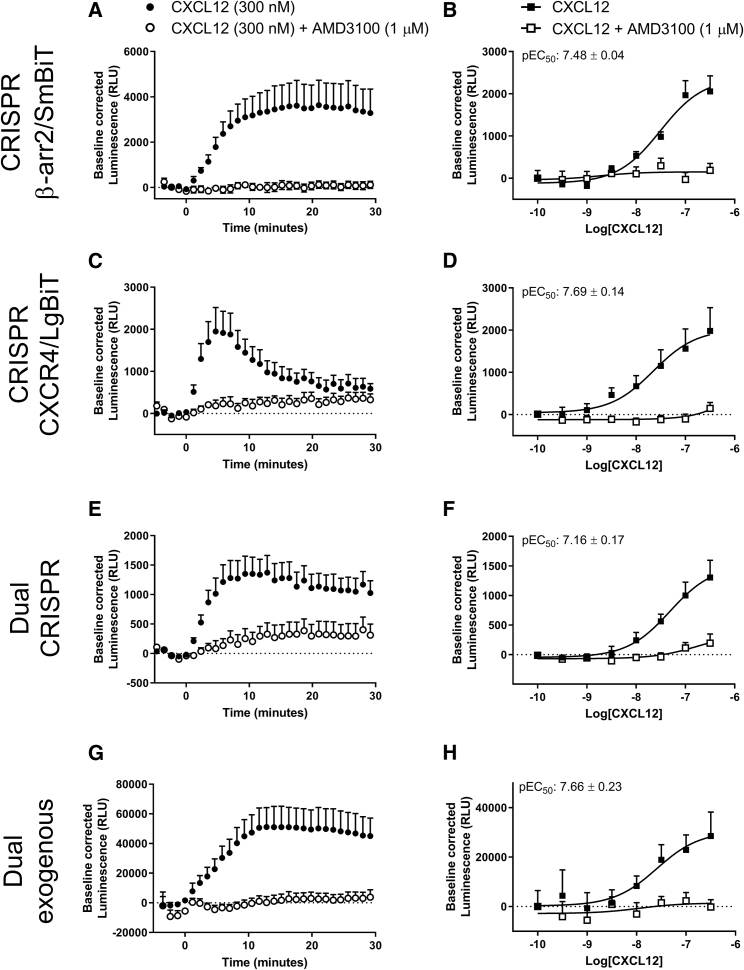
Investigation of β-Arrestin2/SmBiT Recruitment to CXCR4/LgBiT in Genome-Edited HEK293 CellsHEK293 cells expressing (A and B) genome-edited β-arrestin2/SmBiT transiently transfected with CXCR4/LgBiT (CRISPR β-arr2/SmBiT), (C and D) genome-edited CXCR4/LgBiT transiently transfected with β-arrestin2/SmBiT (CRISPR CXCR4/LgBiT), (E and F) both genome-edited CXCR4/LgBiT and genome-edited β-arrestin2/SmBiT (Dual CRISPR), or (G and H) HEK293 cells expressing transiently transfected CXCR4/LgBiT and β-arrestin2/SmBiT (dual exogenous), were stimulated with 300 nM CXCL12 (A, C, E, and G) or increasing concentrations of CXCL12 (0.3–300 nM) (B, D, F, and H) in the absence (black squares and circles) or presence (white squares and circles) of 1 μM AM3100. Points represent mean ± SEM of six (C and D), seven (A, B, E, and F) or eight (G and H) individual experiments performed in triplicate. pEC50 values stated were calculated from response at approximately 5 min after ligand addition. Baseline-corrected luminescence calculated as described in the STAR Methods (see Figures S3 and S4).